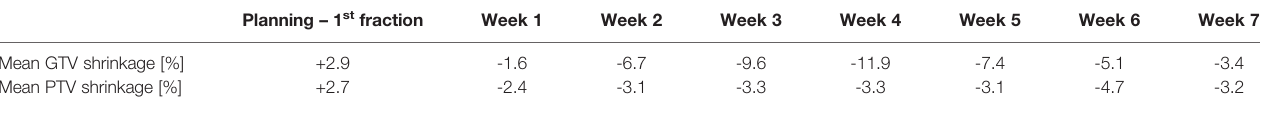
TABLE 2 | Size of gross (GTV) and planning target volumes (PTV) over the course of radiotherapy (negative values correspond to